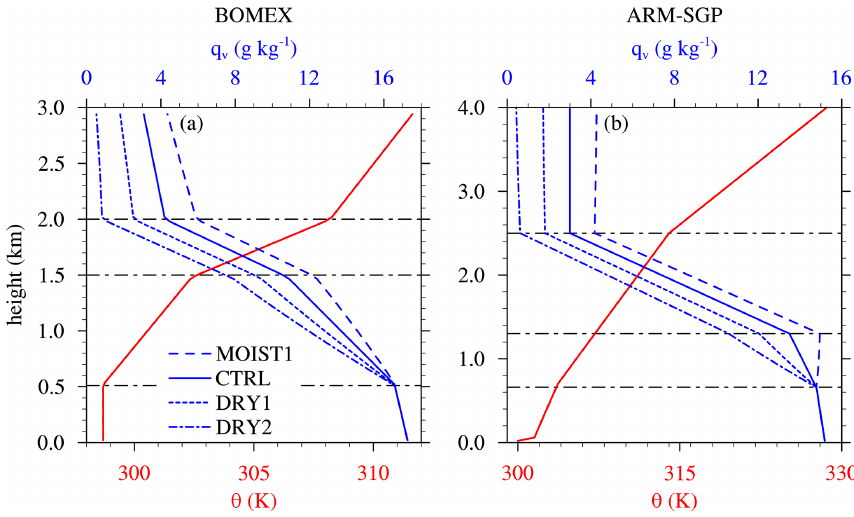
Figure 2. Initial profiles of potential temperature ( θ ) and water vapor mixing ratio ( q v ) for the cloud-layer RH experiments for (a) BOMEX and (b)